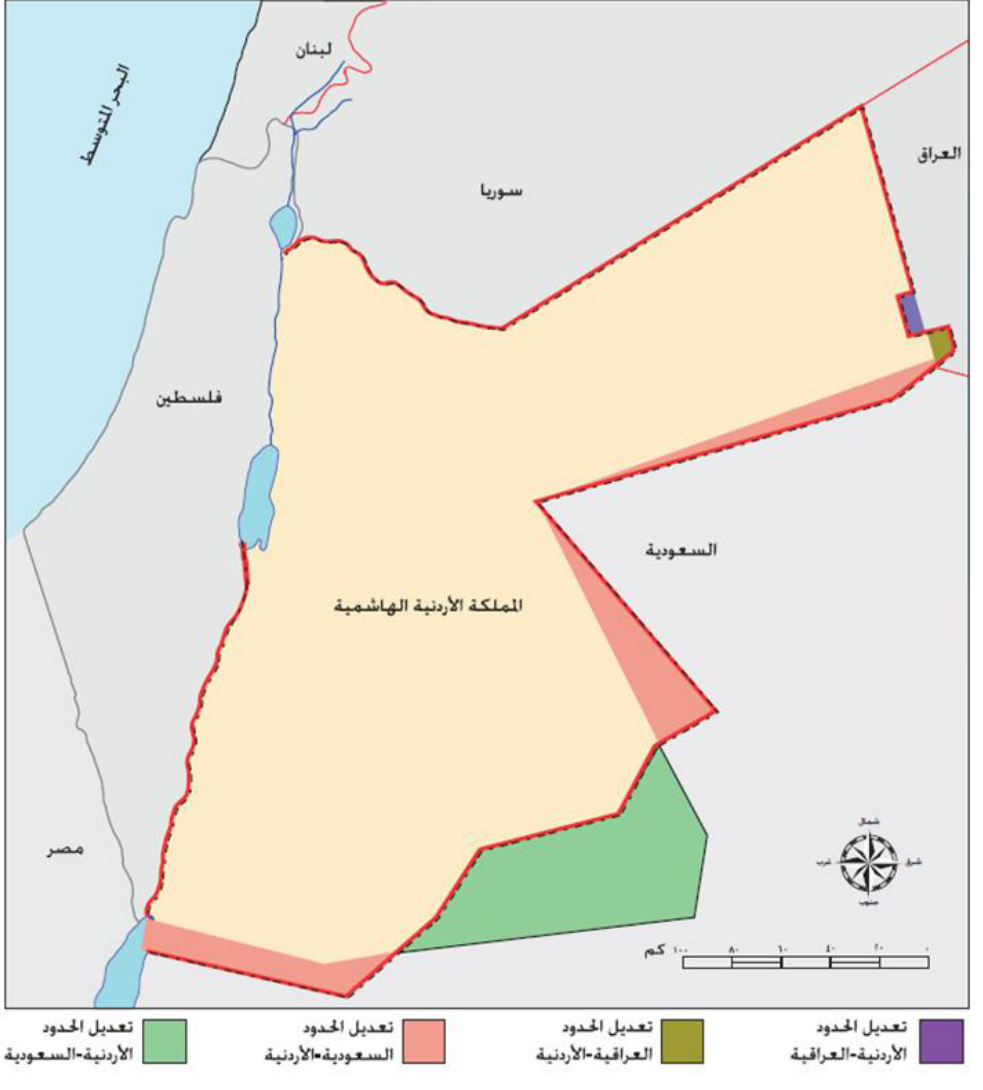
[Legend: Violet: Jordanian-Iraqi Border Adjustment; Khaki: Iraqi-Jordanian Border Adjustment; Pink: Saudi-Jordanian Border Adjustment; Light Green Jordanian-Saudi Border Adjustment]. Geography , Grade 12 (Literature Branch), 2018,